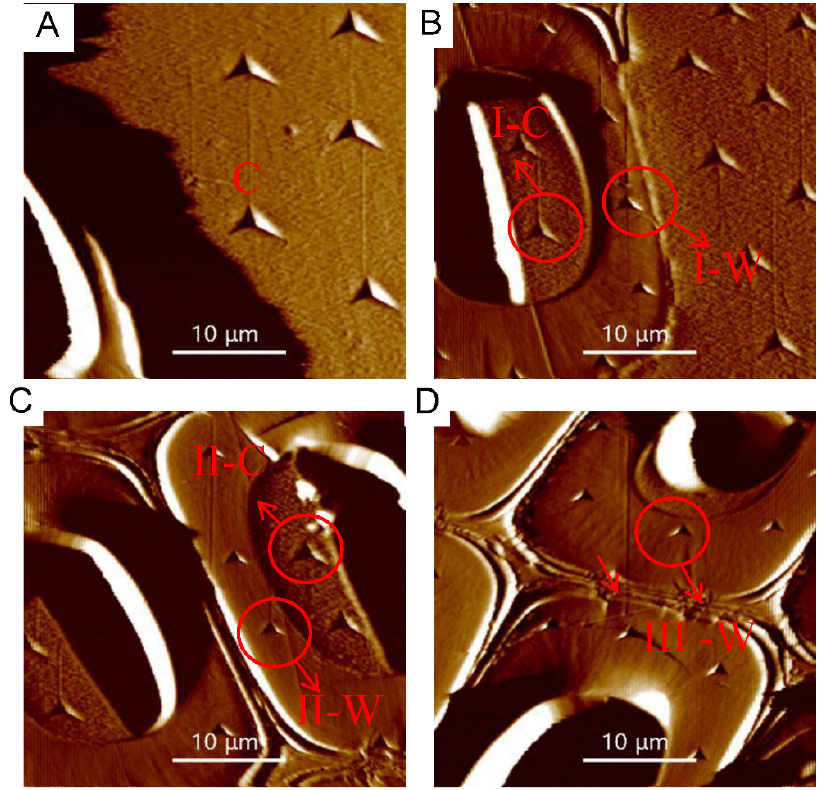
Figure 2. Scanning probe microscopy (SPM) images of test locations and the indents after characterization by nanoindentation: ( A ) indents on the coating layer; ( B ) indents on I-C and I-W; ( C ) indents on II-C and II-W; ( D ) indents on III-W.